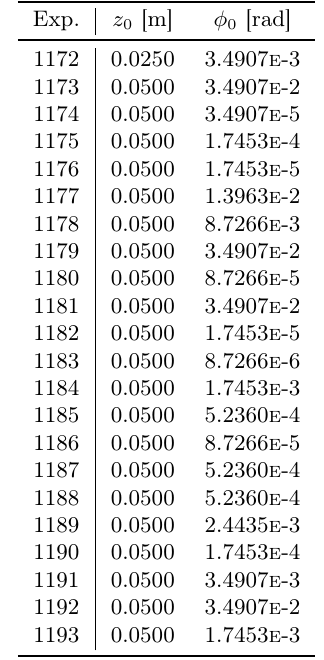
Table 6: Experimental conditions Table 7: Simulation initial conditions